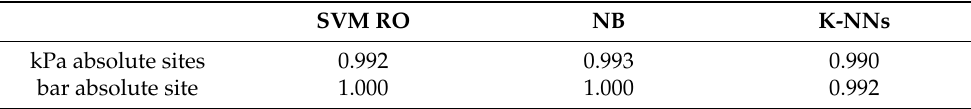
Figure 8. ROC curve for the SVM RO ( a ), NB ( b ) and K-NN classifiers ( c ): training with 10% of non-filtered data and twelve UOMs (continuous line: kPa absolute sites, dashed line: bar absolute site). Table 4. AUC of the SVM RO, NB, and K-NN classifiers.